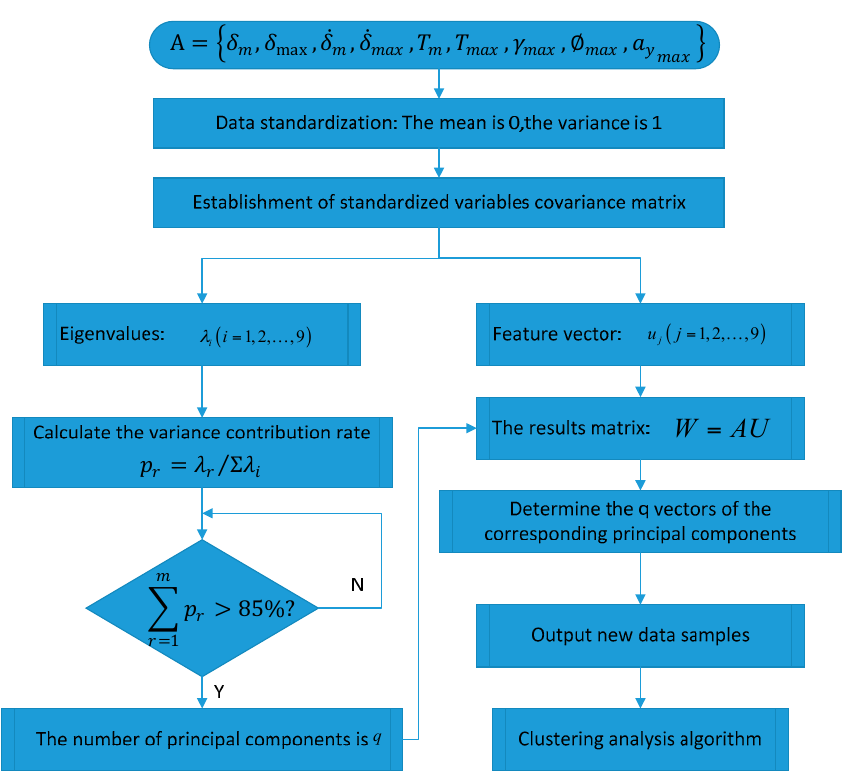
Figure 10. Method of principal component analysis. Table 4. The principal component eigenvalue, contribution rate and cumulative contribution rate.